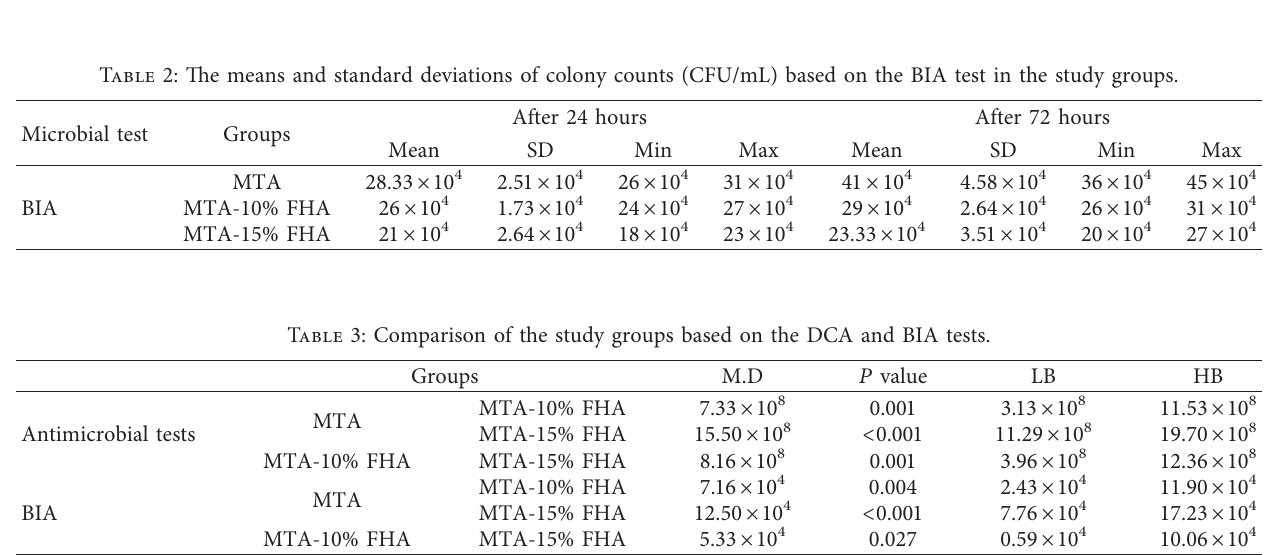
Antimicrobial tests